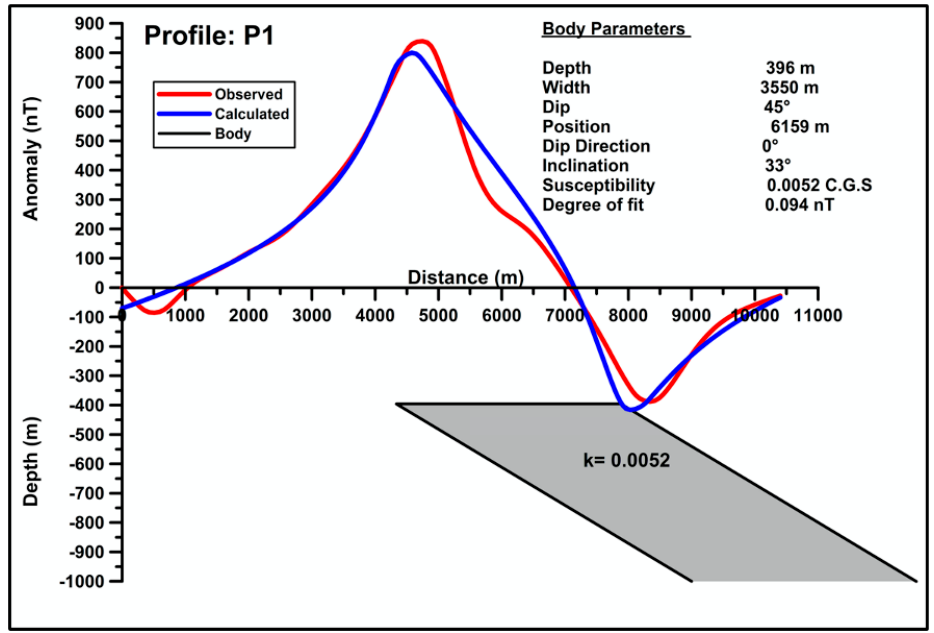
Figure 8. Interpreted 2D depth model for magnetic anomaly.